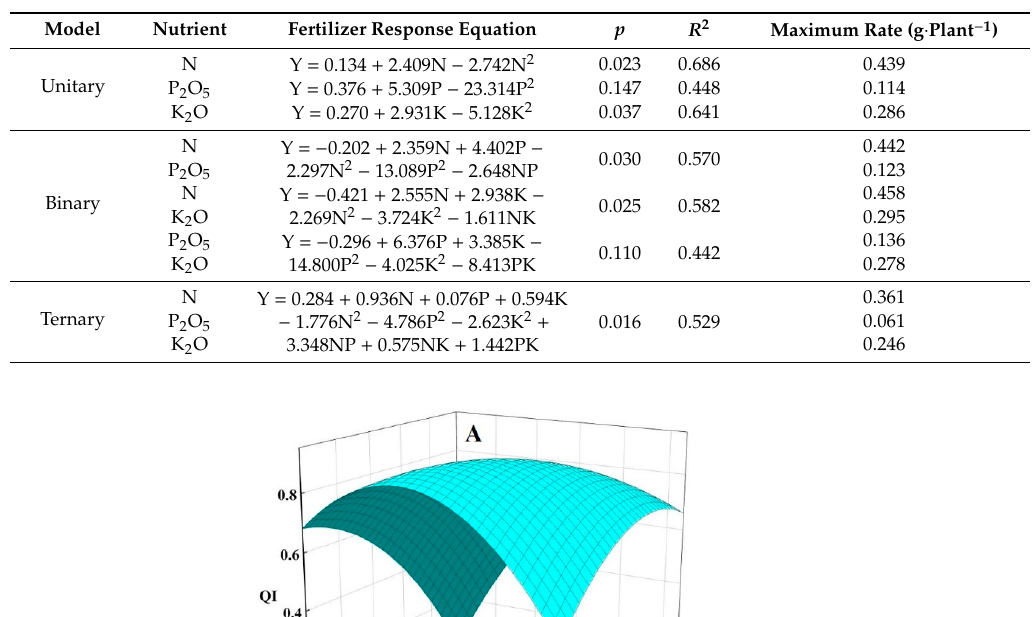
Table 7. N–P–K fertilizer response equations and the recommended fertilizer application rates for optimum Phoebe bournei seedling growth.